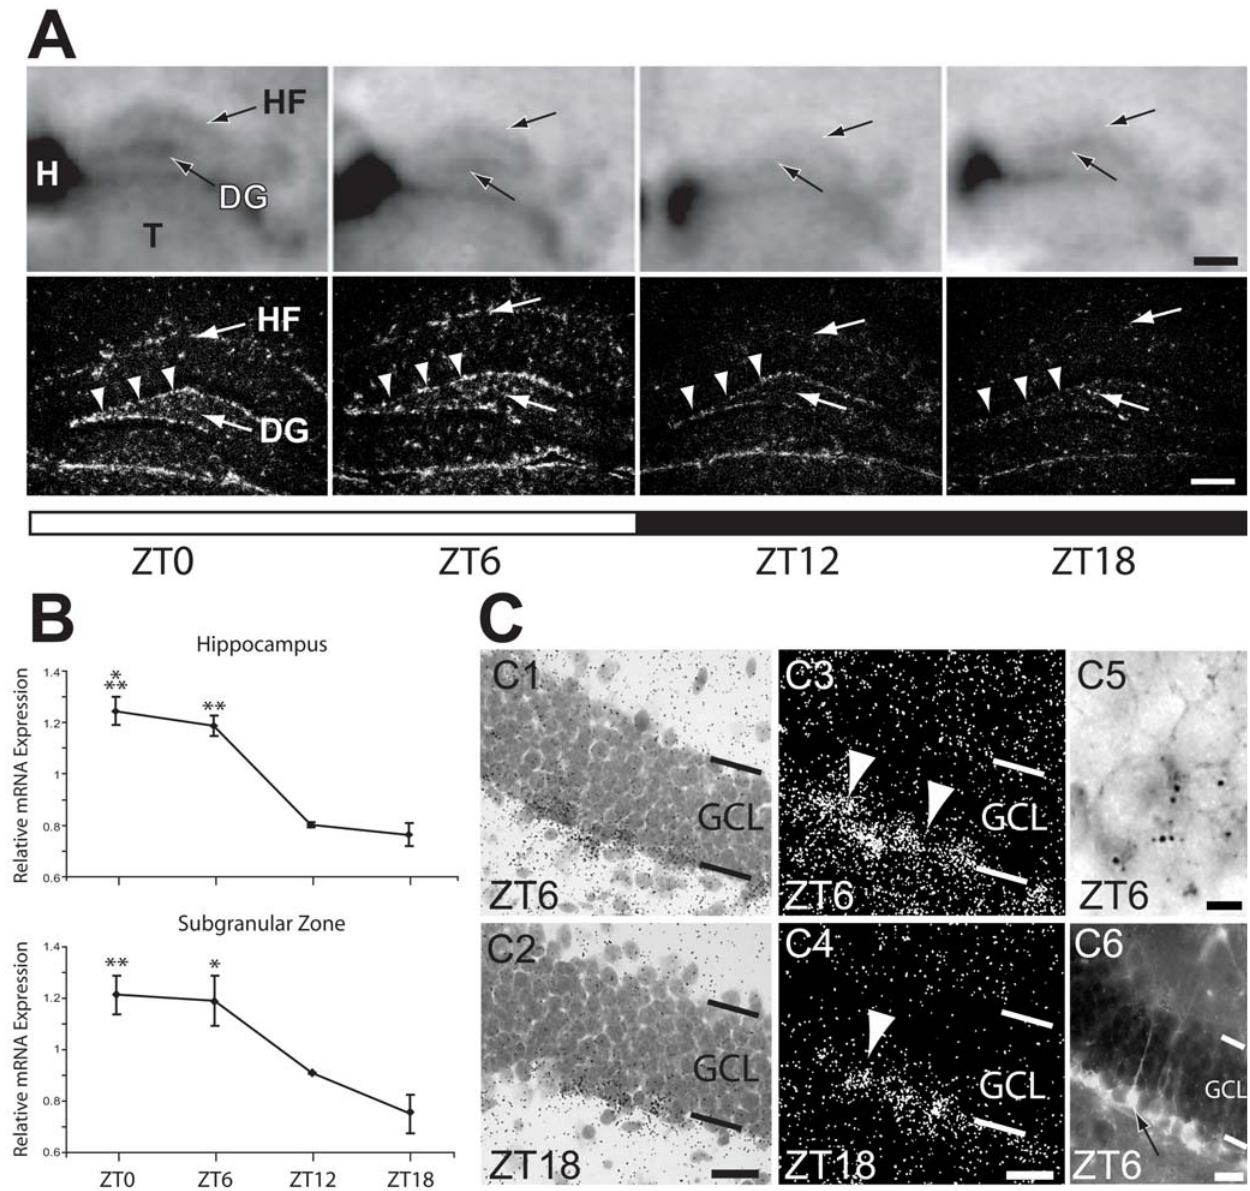
Figure 5. Fabp7 mRNA expression is diurnally regulated in hippocampus and subgranular zone of dentate gyrus. A) In situ hybridization of coronal tissue sections probed for Fabp7 mRNA at four diurnal time points. Top panels, phosphorimages of hippocampus, bottom panels, dark field images of a different set of hybridized sections subjected to emulsion autoradiography. Higher levels of Fabp7 were evident during lights-on. Arrowheads in bottom panels indicate subgranular zone of dentate gyrus (DG). B) Graphic representation of in situ hybridization data indicating elevated levels of Fabp7 mRNA during lights-on in hippocampus (top panel) and subgranular zone (bottom panel). One-way ANOVA (p , 0.001). ***p , 0.001, **p , 0.01 vs. ZT18 (post-hoc Bonferroni). Each value represents the average + / 2 S.E.M. N =2–4 per time point. C) Sections subjected to in situ hybridization for Fabp7 and emulsion autoradiography. Light- (C1, C2) and dark field (C3, C4) micrographs of sections from ZT6 and ZT18, respectively. Arrowheads indicate Fabp7 positive precursor cells in subgranular zone. Sections co-stained for Fabp7 mRNA (dark stain) and nestin mRNA (dark silver grains) identified co-labeled precursors in the subgranular zone (C5). Sections subjected to immunohistochemistry for Fabp7 (C6) revealed radial fibers emanating from stained cell bodies (arrows) as previously described. Bar in upper, lightfield micrographs in A=500 m m; in lower, darkfield micrographs in A=200 m m; in C1,C2=30 m m; in C3,C4=30 m m; in C5=5 m m; C6=25 m m. DG, dentate gyrus; GCL, granule cell layer; H, hebenula; HF, hippocampal fissure; T,